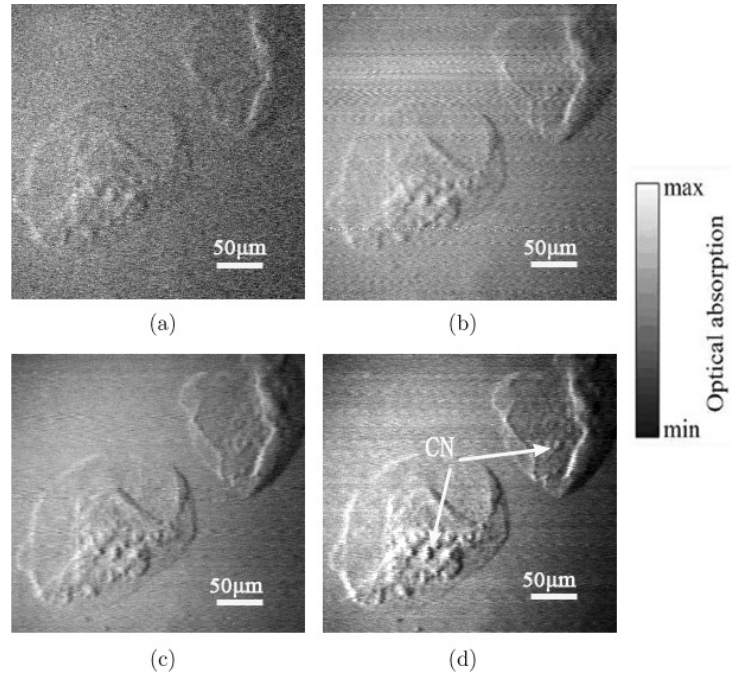
Fig. 4. Comparison of OR-PAM images of oral epidermal cells acquired through simultaneous acquisition with di®erent numbers of sensors. (a) Single-sensor PAM image, (b) two-sensor PAM image, (c) three-sensor PAM image and (d) four-sensor PAM image. CN: cell